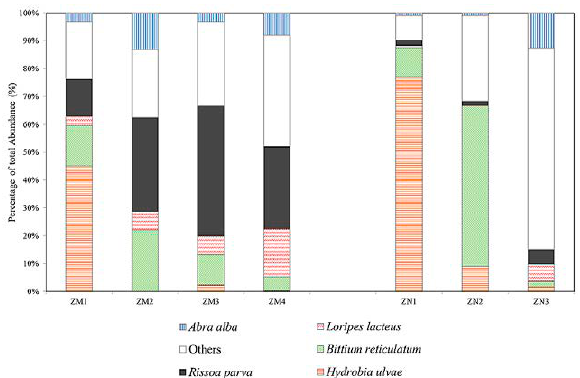
Fig. 4. – Total abundance (%) of the main benthic macrofauna spe- cies observed at the sampling sites of Zostera marina (ZM1-ZM4) and Zostera noltei (ZN1-ZN3) beds.